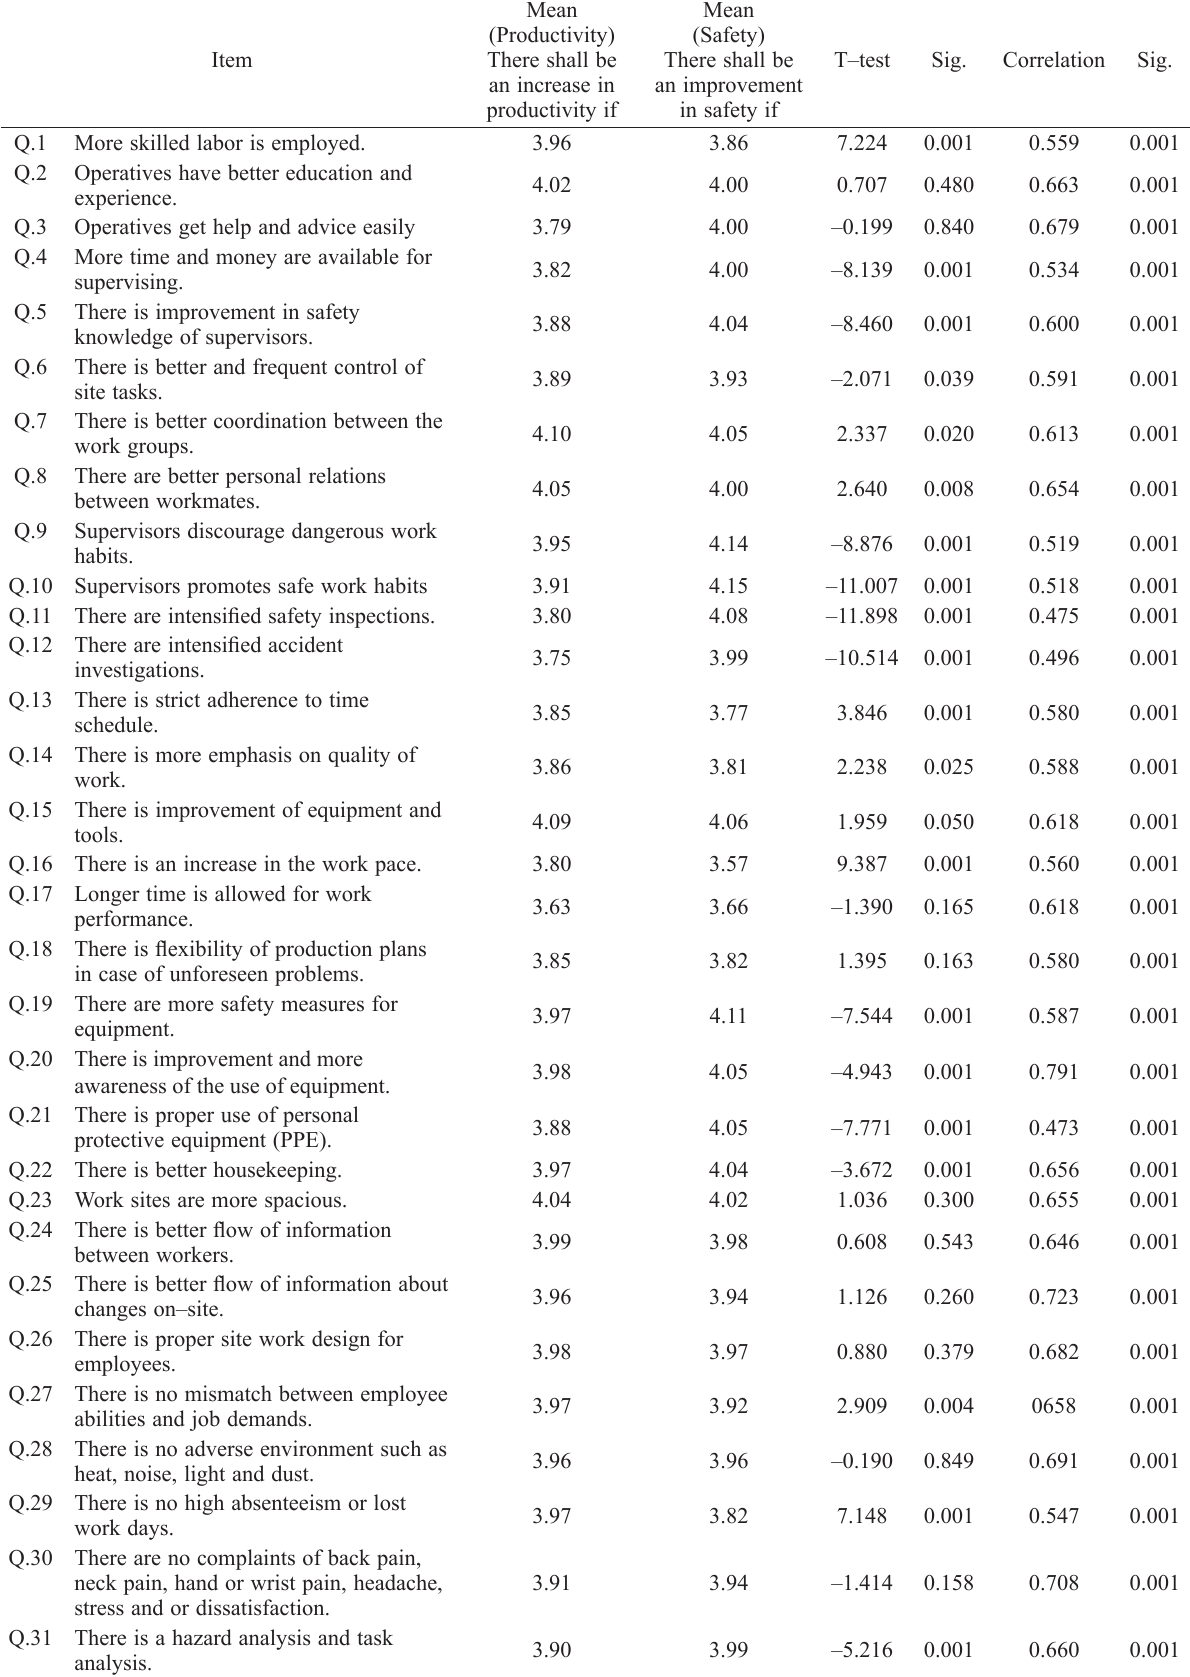
Table 1. Variables for productivity and safety and their correlations